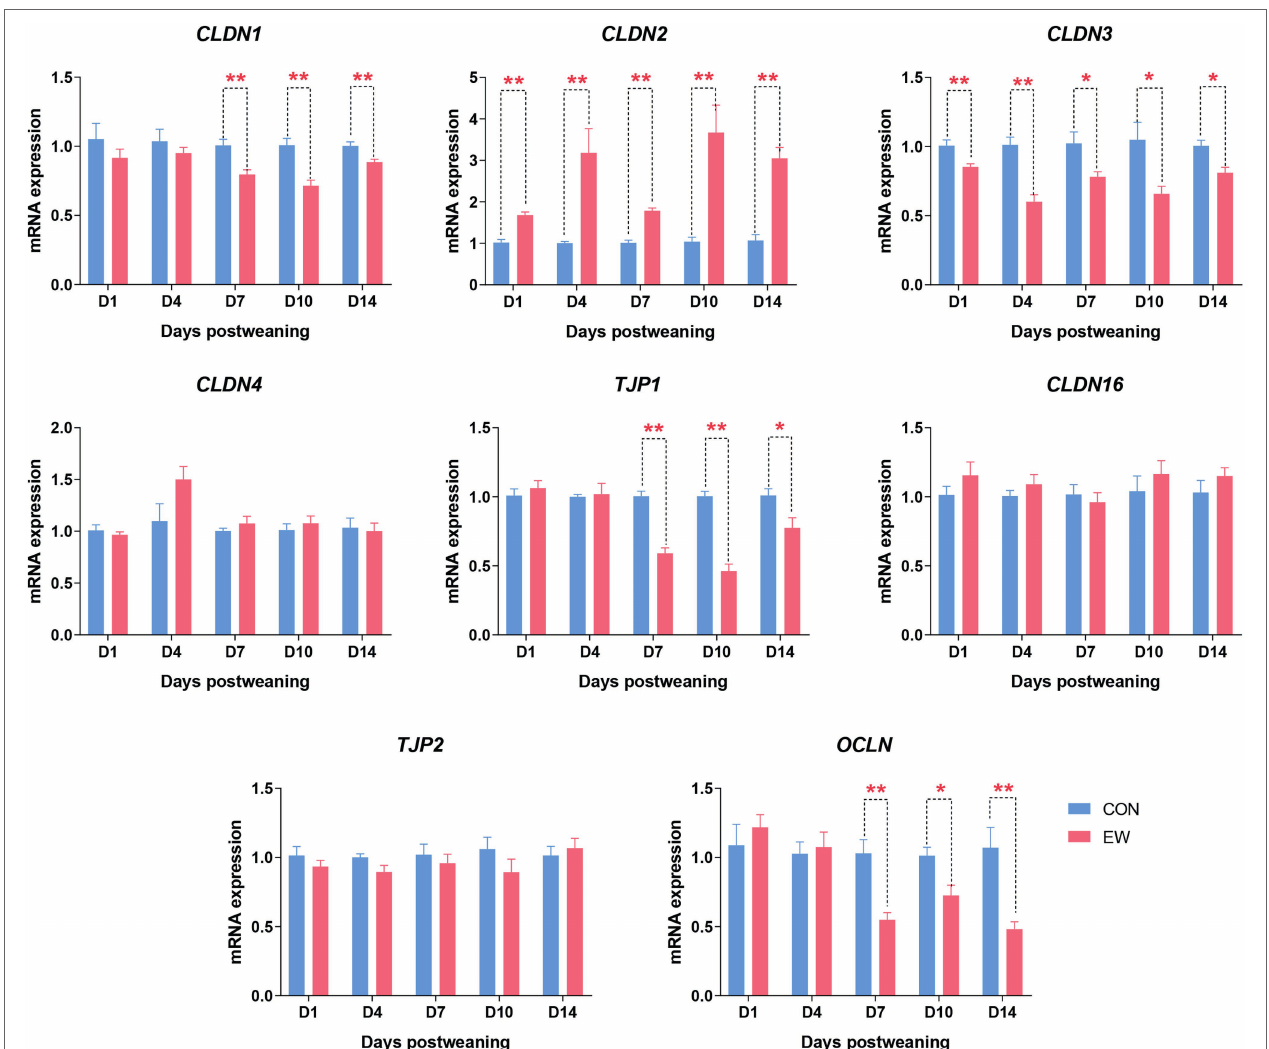
FIGURE 8 | Effects of early weaning on mRNA expression of tight junction proteins in the ileum of squabs. D1, D4, D7, D10, and D14 means 1, 4, 7, 10, and 14 days postweaning, respectively. Values are means with their standard errors of 8 squabs. * and ** mean p < 0.05 and p < 0.01, respectively, within each time points postweaning. CON, control group; EW, early weaning group; CLDN, claudin; OCLN, occludin; TJP, tight junction